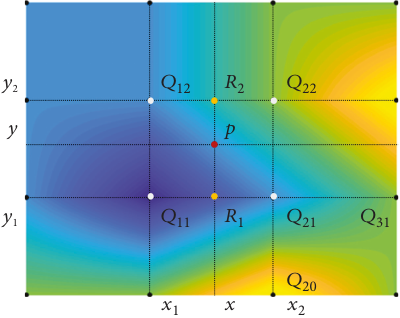
Figure 1: Bilinear interpolation